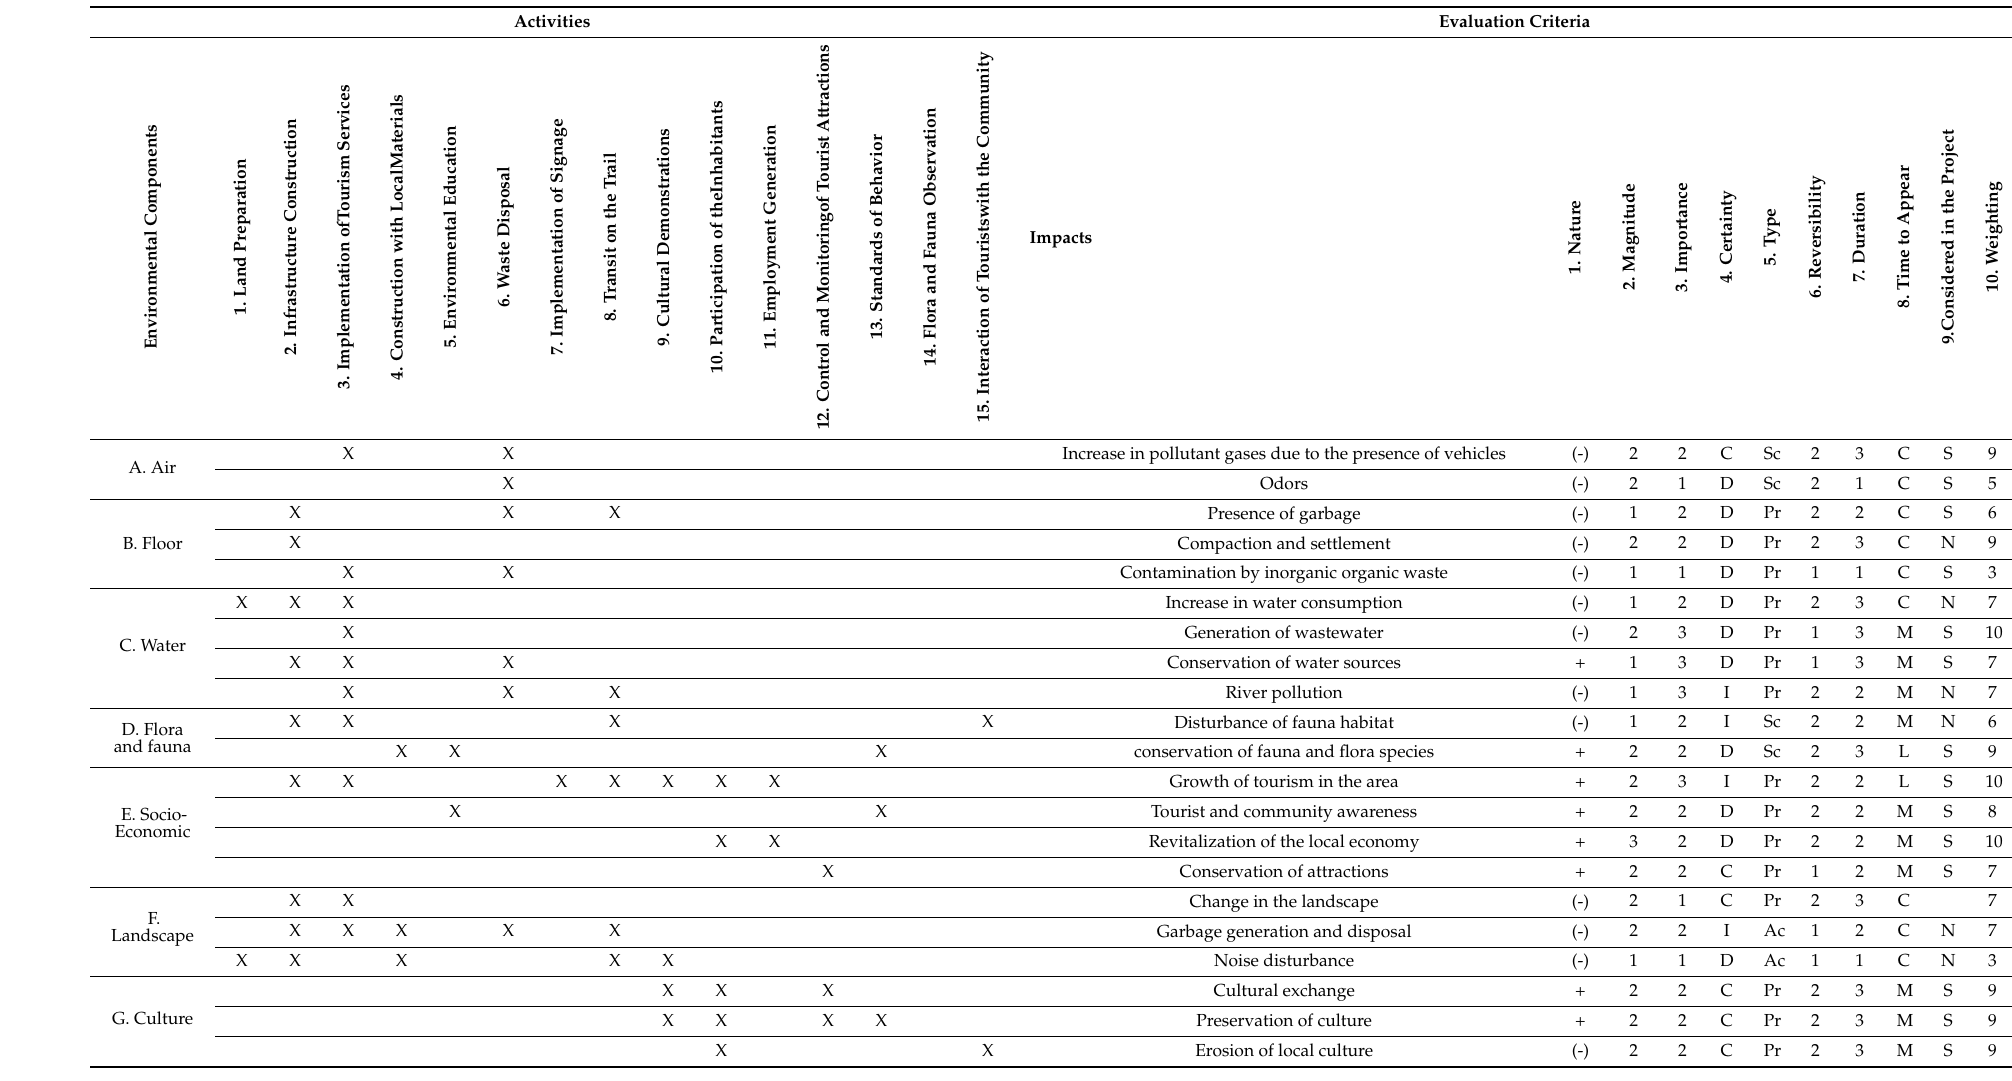
Table 2. L á zaro Lagos